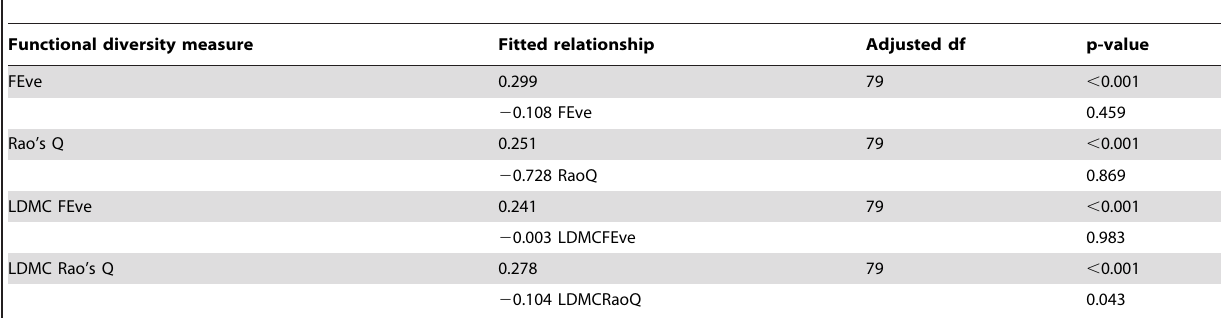
Table 3. Model parameters, parameter probabilities and model fit for relationships between functional evenness (FEve) and Rao’s Q from the full trait list and for LDMC alone and the absolute residuals from the combined trait and climate model described in Table